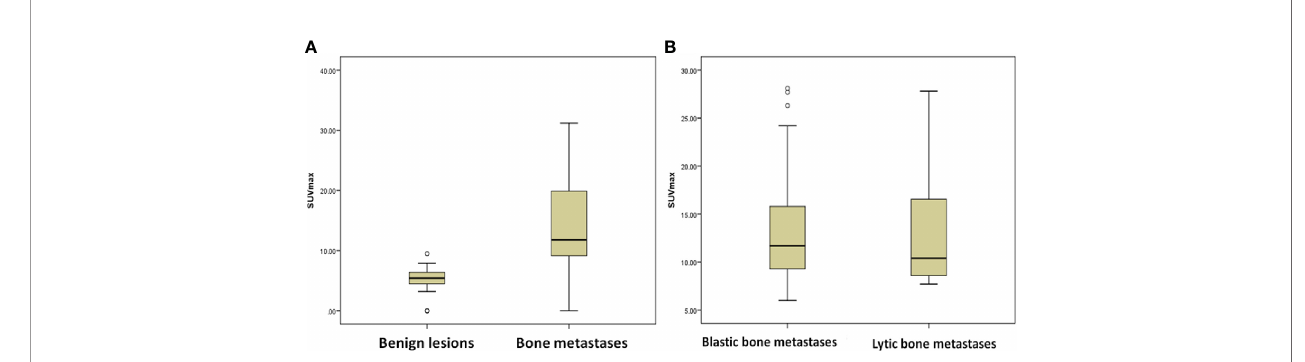
FIGURE 4 | Comparison of SUVmax between different groups in 68 Ga-P15-041 PET/CT. (A) 162 bone metastases and 415 benign lesions. (B) Approximately 72 osteoblastic bone metastases and 82 osteolytic bone metastases.